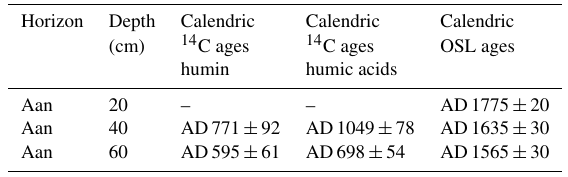
Table 1. 14 C and OSL dates of the plaggic deposits of Valenakker.